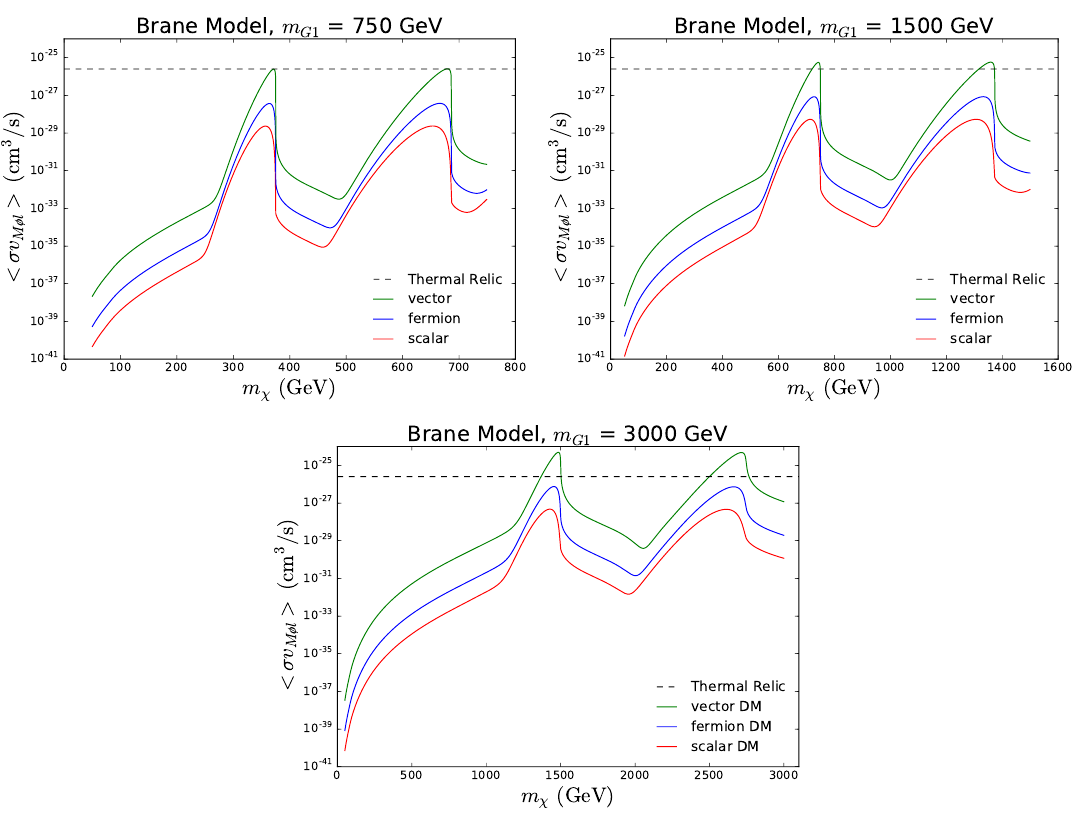
Figure 4 . The thermally averaged cross section times M(cid:28)ller velocity for the benchmark models with all SM (cid:12)elds residing on the IR-brane as a function of the DM mass. The three benchmarks correspond to a lowest KK graviton mass of 750 GeV (top left), 1500 GeV (top right), and 3000 GeV (bottom). The value of h (cid:27)v i associated with the observed relic abundance of DM is shown by the black dashed